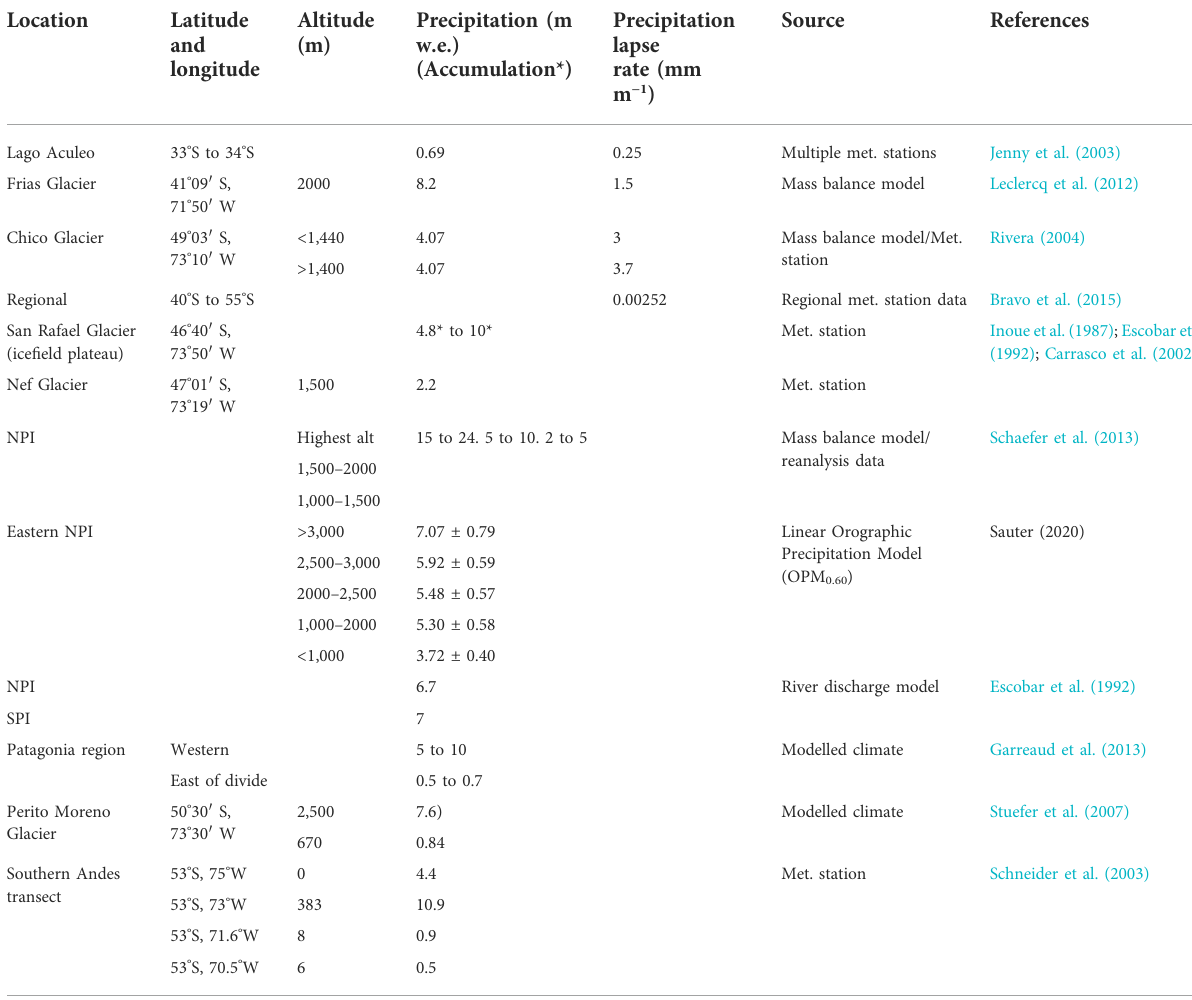
TABLE2ModelledandmeasuredprecipitationandaccumulationdataacrossPatagonia.NPI:NorthernPatagonianIce fi eld.SPI:SouthernPatagonian Ice fi